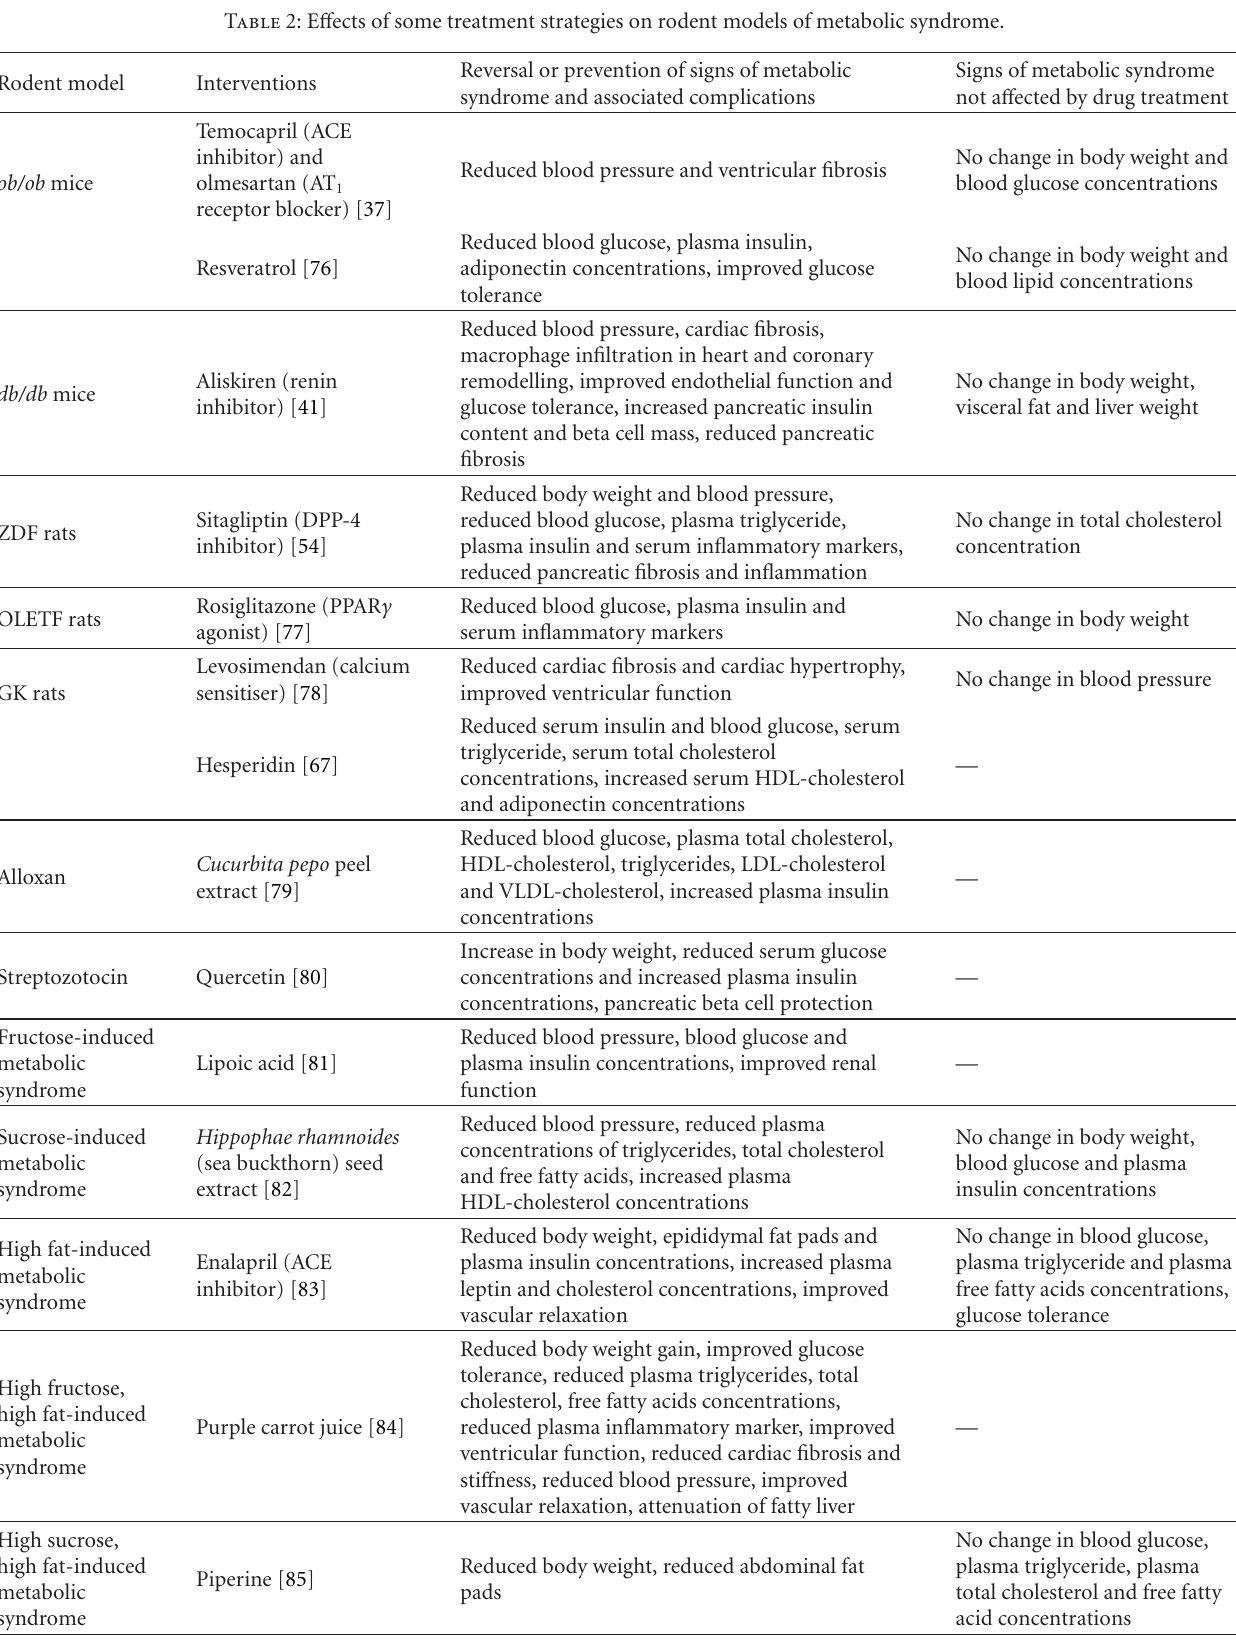
Table 2: E ff ects of some treatment strategies on rodent models of metabolic syndrome. Rodent